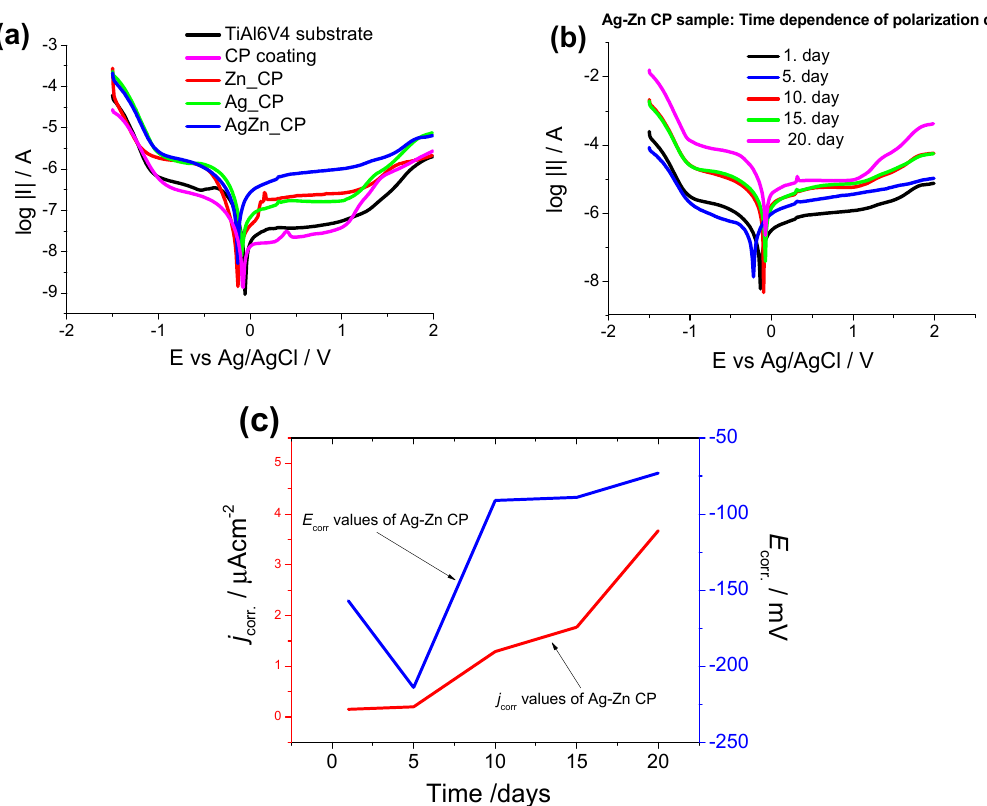
Figure 6. Polarization curves recorded on different samples after 5 days of immersion. ( a ) Time-dependence of potentiodynamic polarization curves recorded on Ag and Zn substituted CP coating, ( b ) as well as the j corr . (red line) and E corr. (blue line) values derived from potentiodynamic curves ( c ). The curves were recorded in conventional Ringer’s solution at 37 °C with a potential scan rate of 1 mv s − 1 .